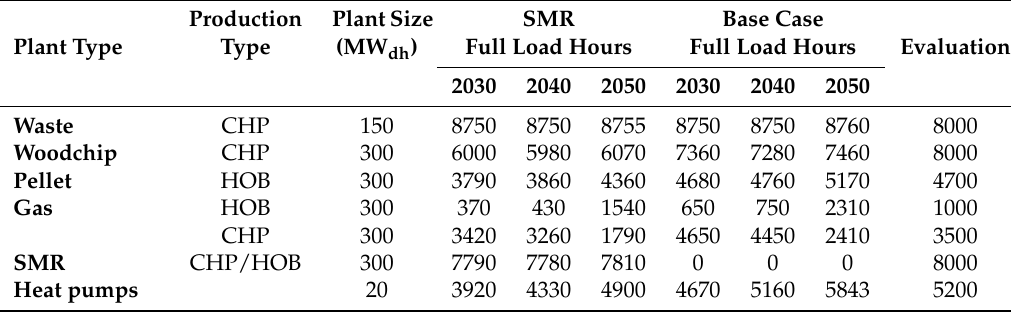
Table 5. The full load hours from the two scenarios and general evaluations for the investment model based on